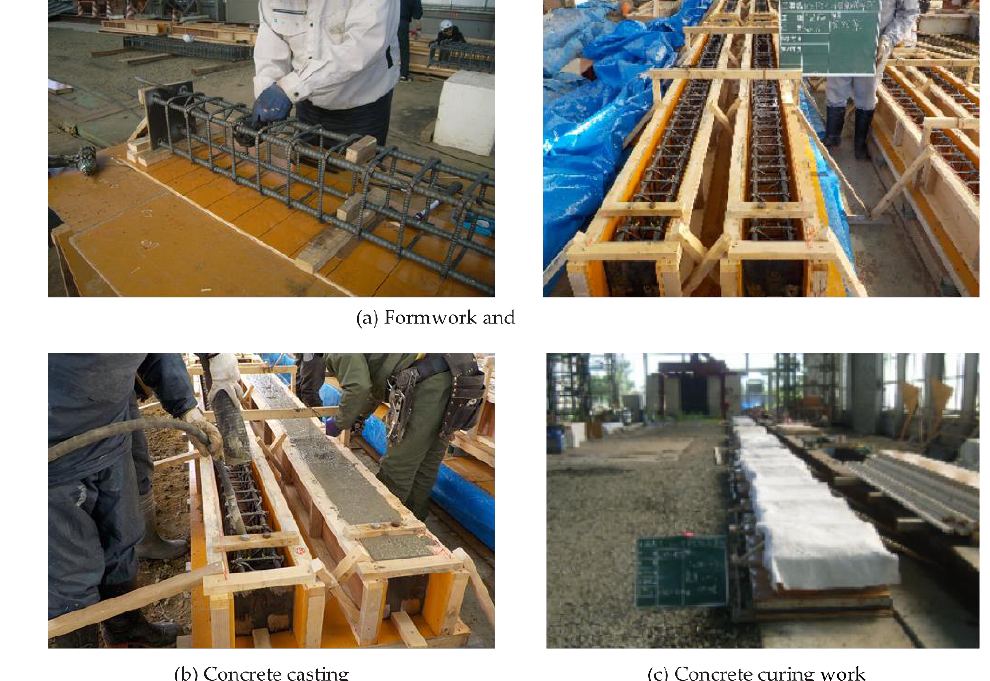
Table 4. Material properties of epoxy resin.